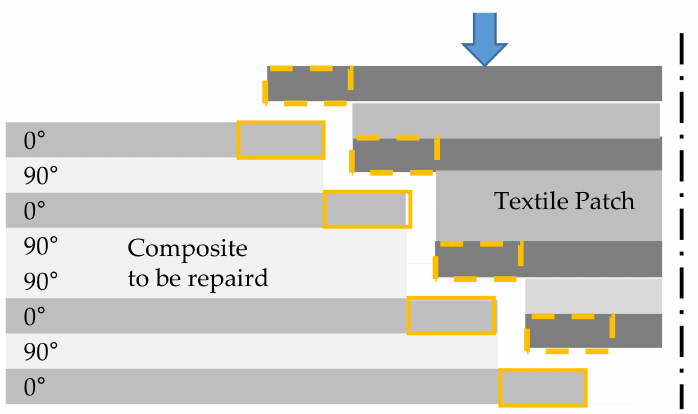
Figure 3. Repair area with the prepared staggered composite with textile fiber ends (yellow), and the textile patch with overlapping fiber ends (yellow dashed